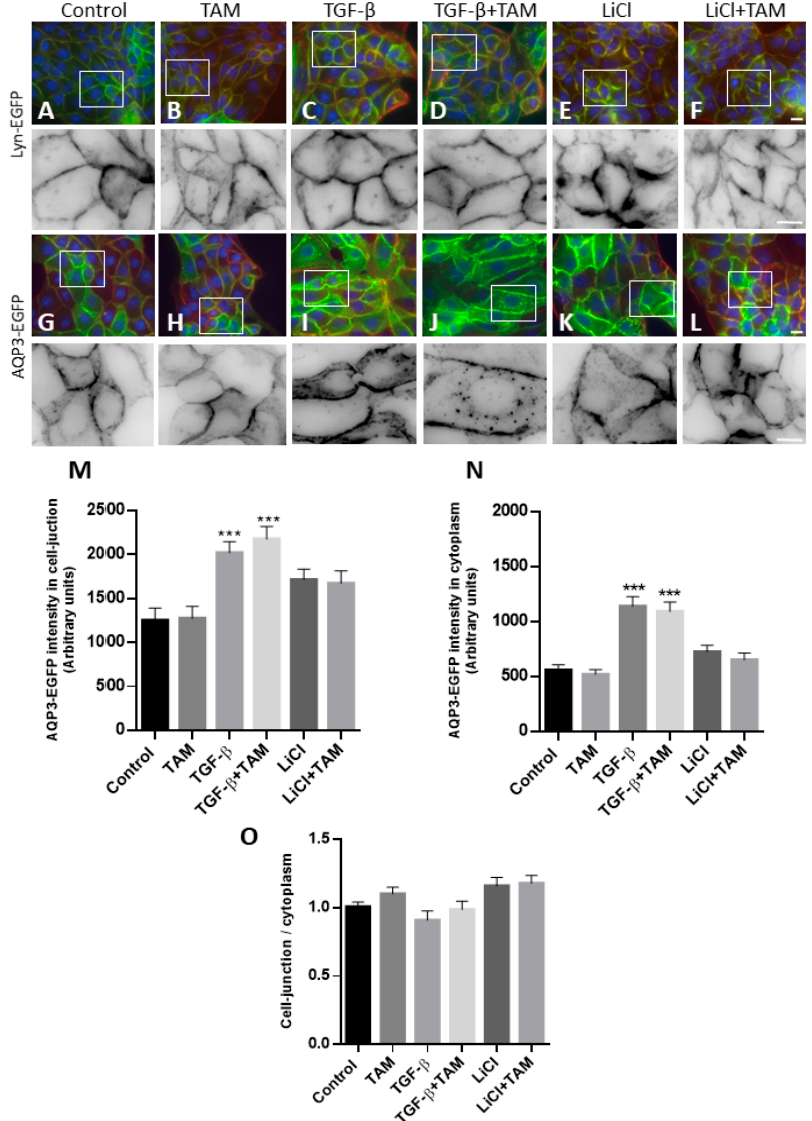
Figure 4. The e ff ect of TAM treatment on AQP3-EGFP localization in stably transfected MDCK cells. ( A – L ): Representative immuno fl uorescence images of MDCK stably expressing AQP3-EGFP ex- posed to TGF- β , LiCl, and TAM. ( A – F ): Lyn-EGFP-MDCK, where EGFP is targeted to membranes by the Lyn kinase anchoring sequence. Below shows the insert in grey scale. ( G – L ): AQP3-EGFP in colored and in zoomed gray scale below. Green fl uorescence represents AQP3-EGFP, red represents bundled actin (phalloidin), and blue color represents the nuclei (Hoechst). Scale bar 15 µm. ( M ): Quanti fi cation of AQP3-EGFP maximum intensity in the cell-cell junction of transfected cells. ( N ): Quanti fi cation of AQP3-EGFP mean intensity in the cytoplasm. ( O ): The ratio of the AQP3-EGFP intensity in the cell-cell junction over the intensity in the cytoplasm. Data are from 4 di ff erent exper- iments based on 6 images for each treatment per experiment. Each bar represents the mean ± SEM. p < 0.001 was considered statistically signi fi cant, indicated by ***.